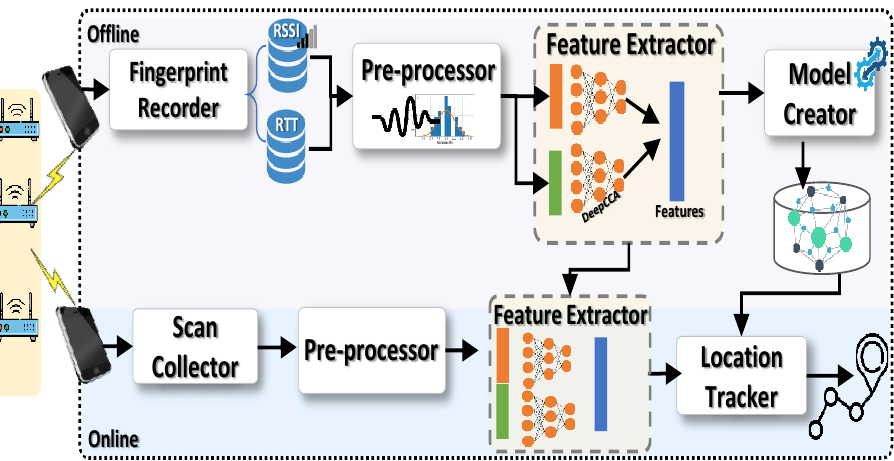
Figure 2. RRLoc system